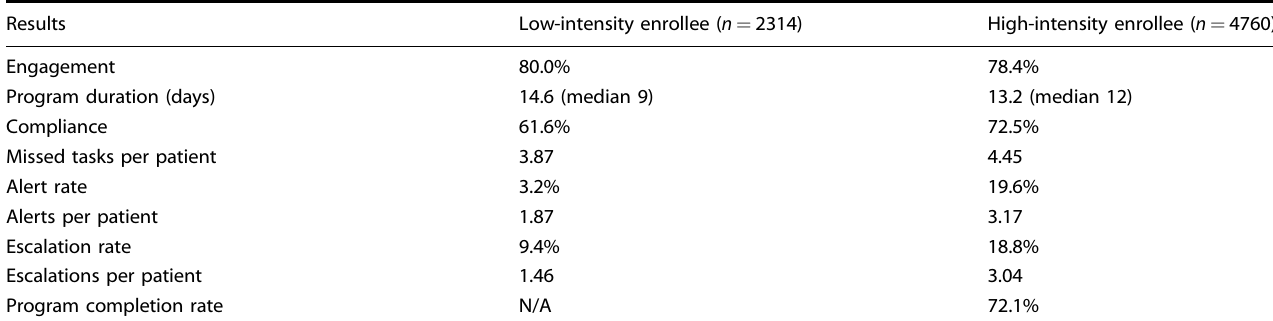
Table 5. COVID-19 RPM program digital engagement, compliance, alerts, and escalations.